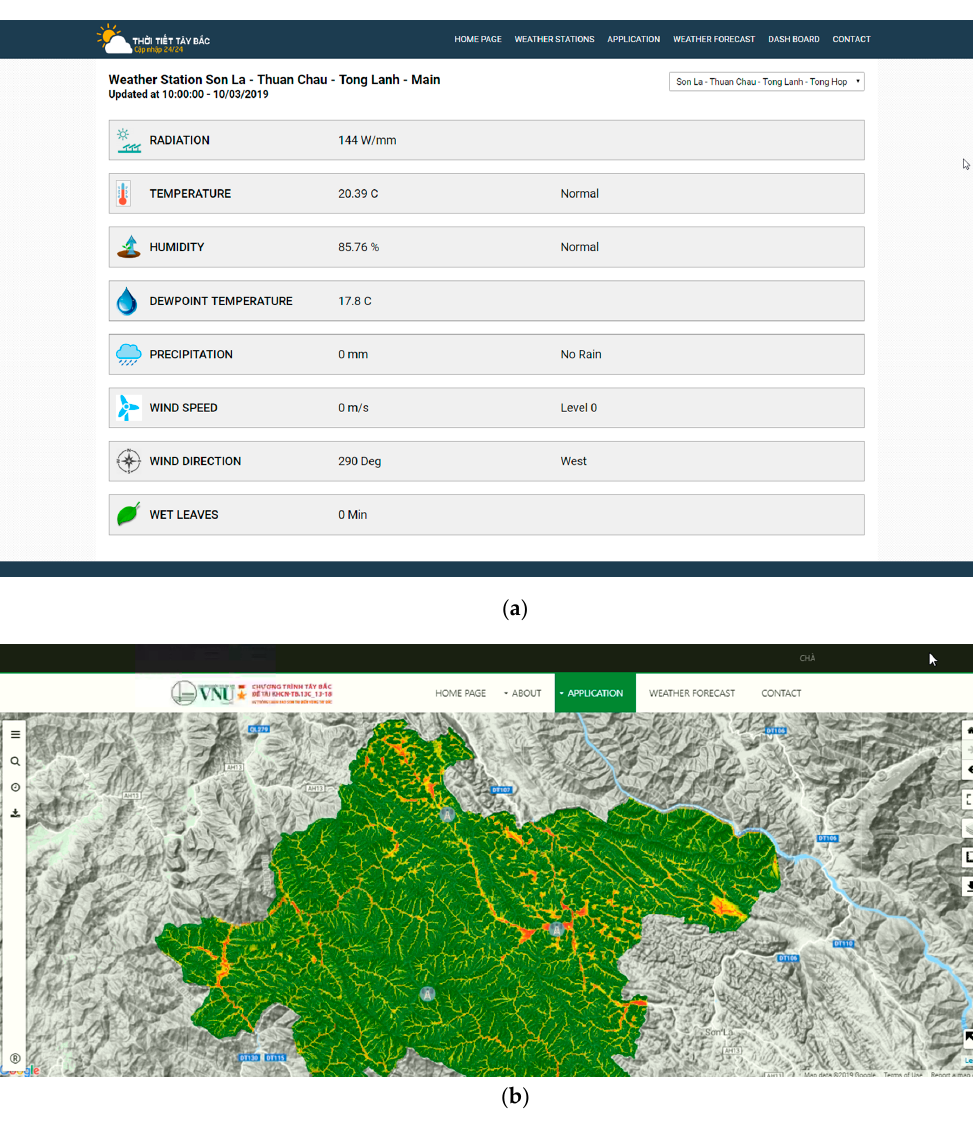
Figure 9. Main interface of the software ( a ) and the risk-warning website ( b ).